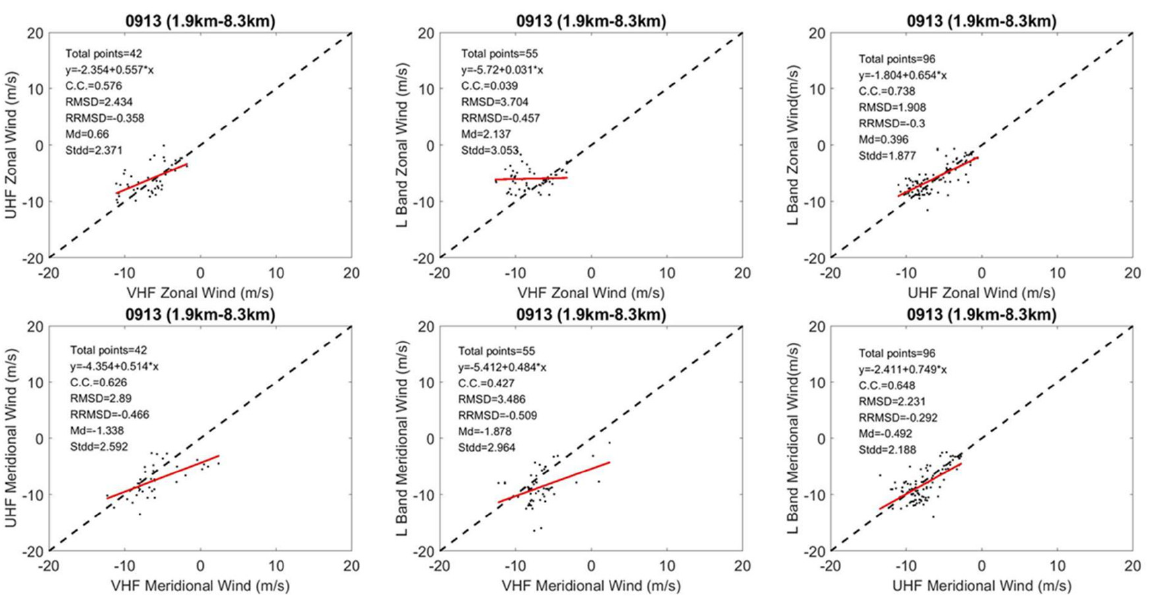
Figure 12. Comparison of zonal ( upper ) and meridional ( lower ) wind velocities between 52 MHz VHF radar, 449 MHz wind profiler, and 1290 MHz wind profiler for precipitation conditions.